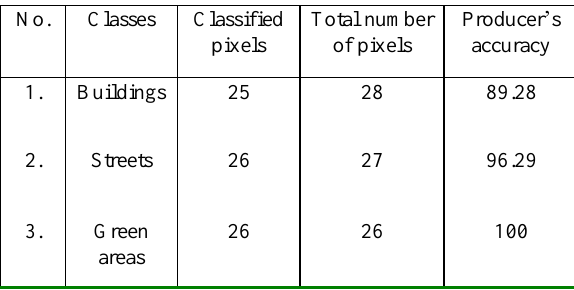
Table 12 . Producer’s accuracy for the image from 2017